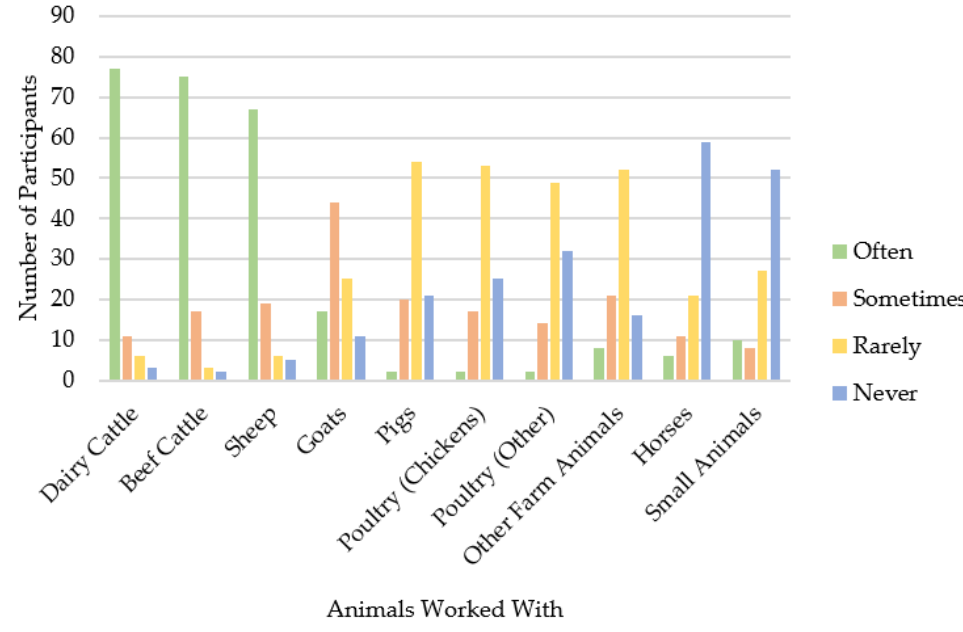
Figure 2. Participants’ responses to “How often do you look after the following animals?”. The survey link was accessed by 132 participants; in total, 17 did not progress beyond the information sheet and consent form, and 18 completed demographic information only, leaving 97 participants who completed at least the vignette (see Figure 3 for randomiza- tion to conditions and participant numbers completing subsequent measures). The values